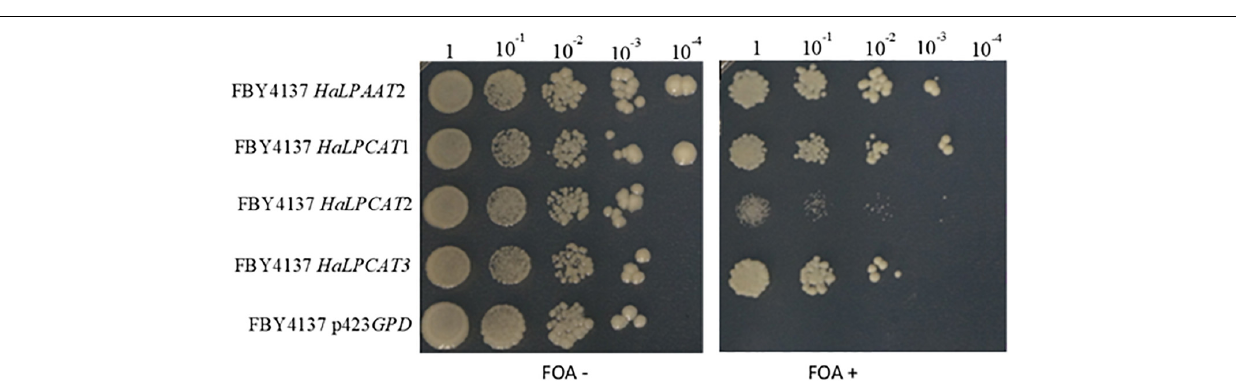
FIGURE 4 | Complementation of the slc1 (cid:49) slc4( (cid:49) Saccharomyces cerevisiae mutant FBY4137 harbouring pGREG546: Sc SLC1) with the three HaLPCAT isoforms, using 5-fluoroorotic acid (FOA) as a selective agent. The strains are displayed in rows and the dilutions in the columns. The LPAAT2 gene from sunflower was used as a positive